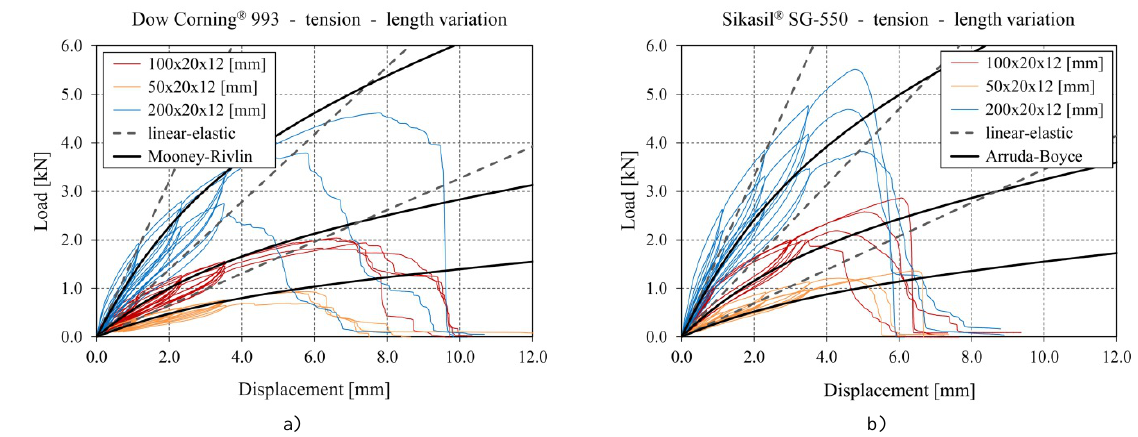
Fig. 6 Load vs. displacement results from the tensile tests on linear adhesive joints with different lengths compared to results obtained by finite element simulations for a) joints with Dow Corning ® 993 and b) joints with Sikasil ® SG-550.